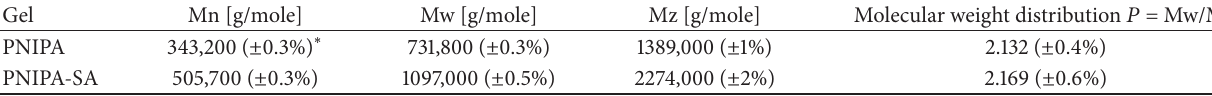
Table 1: Molecular weights and molecular weight distributions of linear gels.